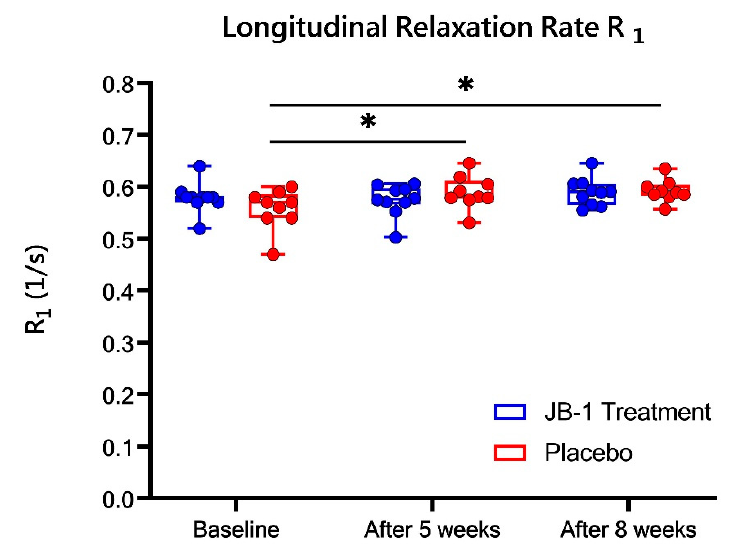
Figure 3. Longitudinal relaxation rate R 1 in JB-1 (N = 10) treatment and placebo (N = 9) groups at baseline and after five and eight weeks stress protocol. Data are presented as median ± min/max. * p < 0.05, one-way Friedman’s ANOVA ( χ 2 statistic) analysis for determination of time effect.